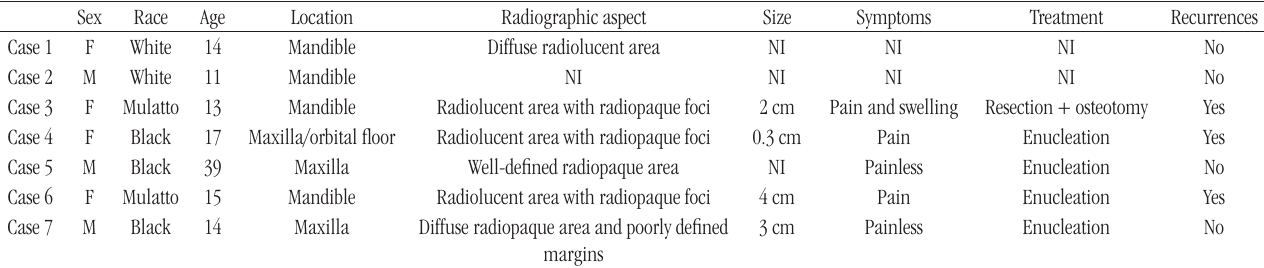
taBLE 1 – Distribution of JOF cases in relation to radiographic and clinical aspects and treatment